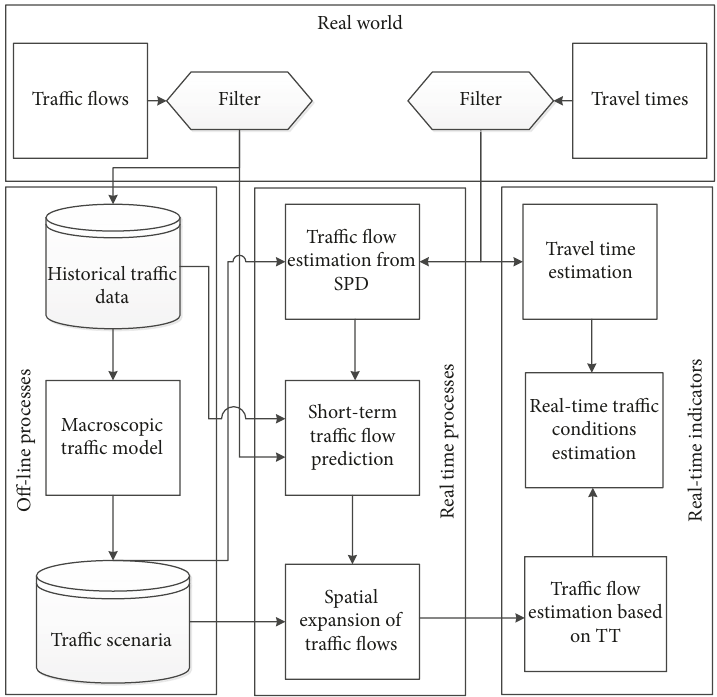
Figure 3: Framework for real-time data processes and services in